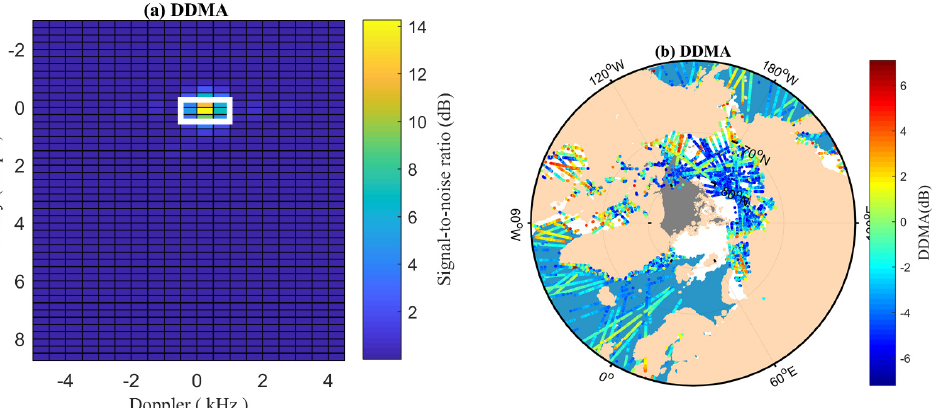
Figure 4. ( a ) The range of calculating Delay-Doppler Map average (DDMA) is marked by the white box, which expands 3 delay bins and 3 Doppler shifts centered at the peak signal-to-noise ratio (SNR) point. ( b ) The distribution of DDMA compared with the OSISAF SIT map. The open water (OW) is described by the light blue color. The white and gray represent the first-year ice (FYI) and multi-year ice (MYI).